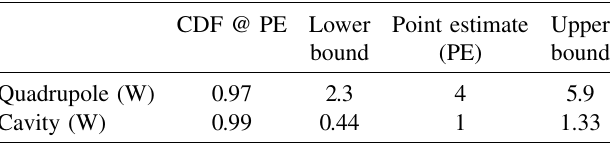
TABLE VIII. Beam loss estimates (PE) and 95% bootstrap confidence intervals.